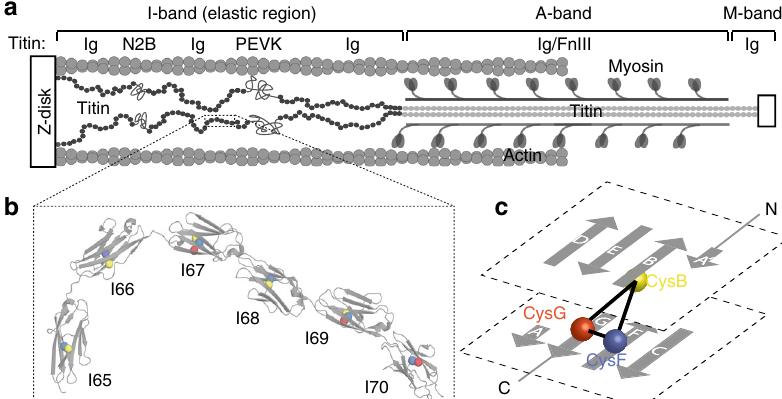
Fig. 1 Conserved cysteine positions in the I65 – I70 fragment of titin. a Schematic architecture of one half of the sarcomere. The titin fi lament spans across the contractile unit and its elastic properties arise from its extensible I-band region where Ig modules ( fi lled black circles) can mechanically unfold and refold. The two entropic springs N2B and PEVK are also depicted as unstructured chains. Gray circles represent the repetition of Ig and fi bronectin domains (FnIII) in the A- and M-band. b Crystal structure of the rabbit titin segment I65 – I70 (pdb: 3B43). This 566 amino acid-long portion of proximal titin is organized in six tandem Ig modules represented in gray. Cysteines are marked by spheres, which are colored according to their position in the Ig secondary structure topology. Cysteines in β -strands B, F and G are shown in yellow, blue and red, respectively. c Scheme of the topology of a typical Ig domain of titin 50 , which displays the arrangement of the three clustered cysteines CysB, CysF and CysG. CysF and CysG appear in two adjacent β -strands whereas CysB is located in the opposite β -sheet (upper